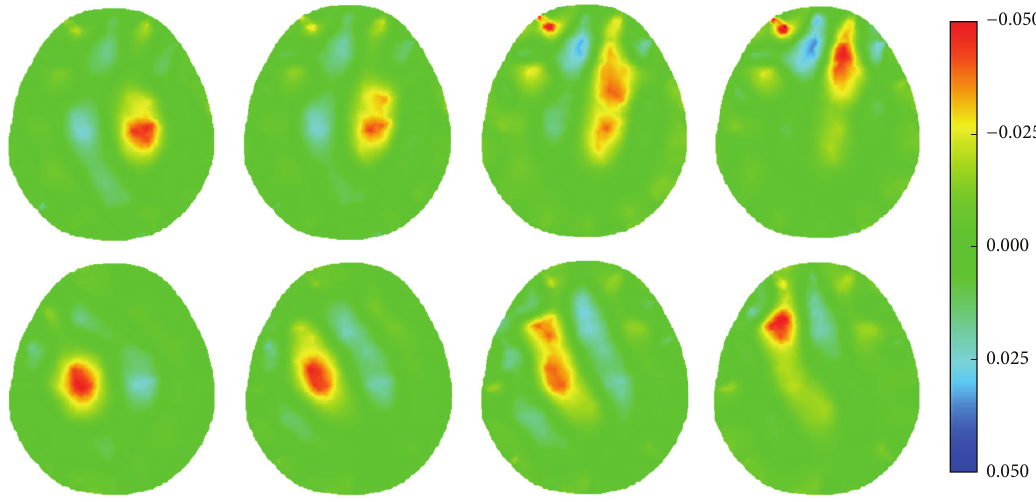
Figure 25: SEIT reconstructions of a simulated hematoma at different locations of the phantom.